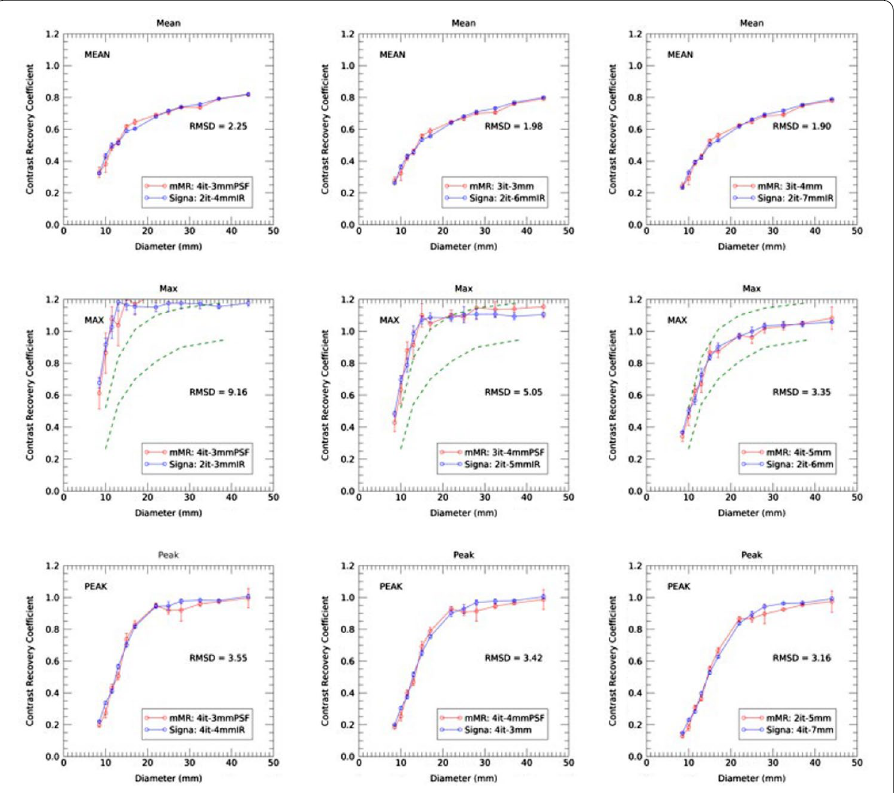
Fig. 6 Matching CRC curves for mean (top), max (middle) and peak values (bottom) for 5 min of data corresponding to three optimization scenario: (left) optimized for best resolution or highest CRC values, (middle) optimized for both resolution and RMSD and (right) for best RMSD. The corresponding RMSD values are indicated in each panel. Results from the Siemens Biograph mMR are in red and from the GE Signa are in blue. The dashed lines represent the EANM limits on CRC